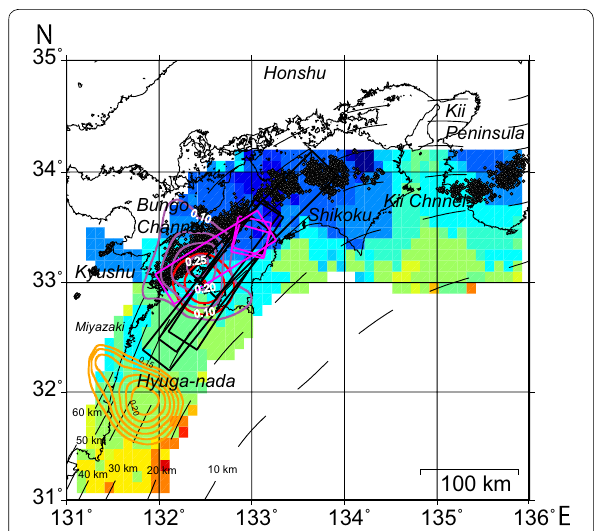
Fig. 2 Spatial distribution of catalog completeness magnitude, M c , estimated using the maximum curvature method (Wiemer and Wyss 2000) on a grid with 0.1° horizontal spacing. Events were extracted in a 35-km radius around each node. Purple and red contours represent isoslip values due to 2003 and 2010 SSEs in the Bungo Channel (Ozawa et al. 2013; Ozawa 2017), with labels in meters and an increment of 0.05 m. Orange contours represent the cumulative slip distribution due to 1997, 2005, 2007, and 2009 SSEs in southern Miyazaki district (Yarai and Ozawa 2013), with labels in meters and an increment of 0.01 m. Purple and black rectangles represent faults corresponding to SSEs from 2004–2006 to 2011–2013 in western Shikoku (Takagi et al. 2016). Gray circles show LFE locations obtained from the JMA